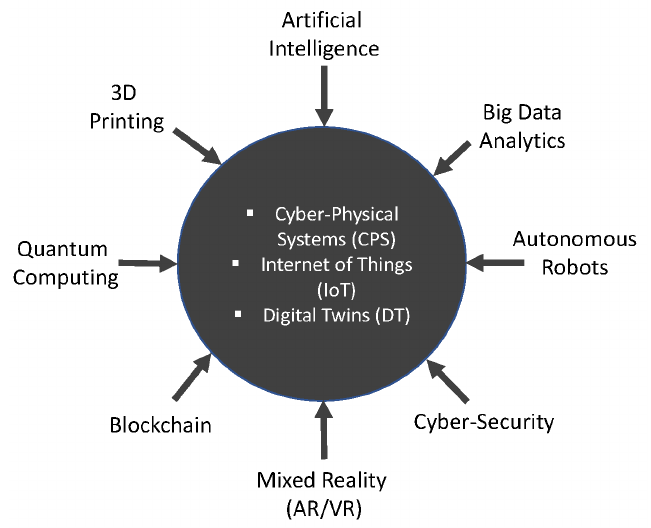
Figure 17. Building